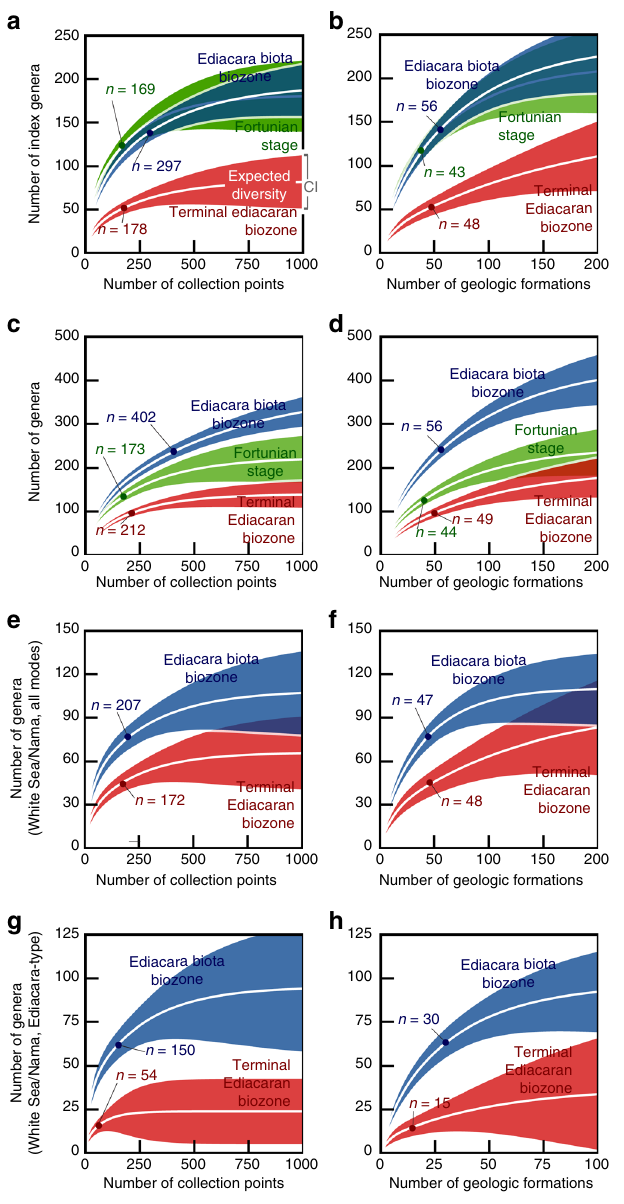
Fig. 7 Sample-based rarefaction and extrapolation of biozone diversity. The sample-based rarefaction and extrapolation curves show generic richness vs. sampling intensity for various subsets of the data (see Methods). For a given sampling intensity level and biozone, diversity is the number of macrofossil body genera expected when that number of samples is drawn at random without replacement from the biozone. The mean values are bracketed by 95% con fi dence interval (CI) envelopes 68 (see Methods). Dots indicate current sampling levels, i.e., the total numbers of samples in the dataset. a , b Data include only stratigraphic index fossil genera (taxa in Fig. 4; Supplementary Fig. 13). c , d Data include all genera, including discs, possible synonyms, and